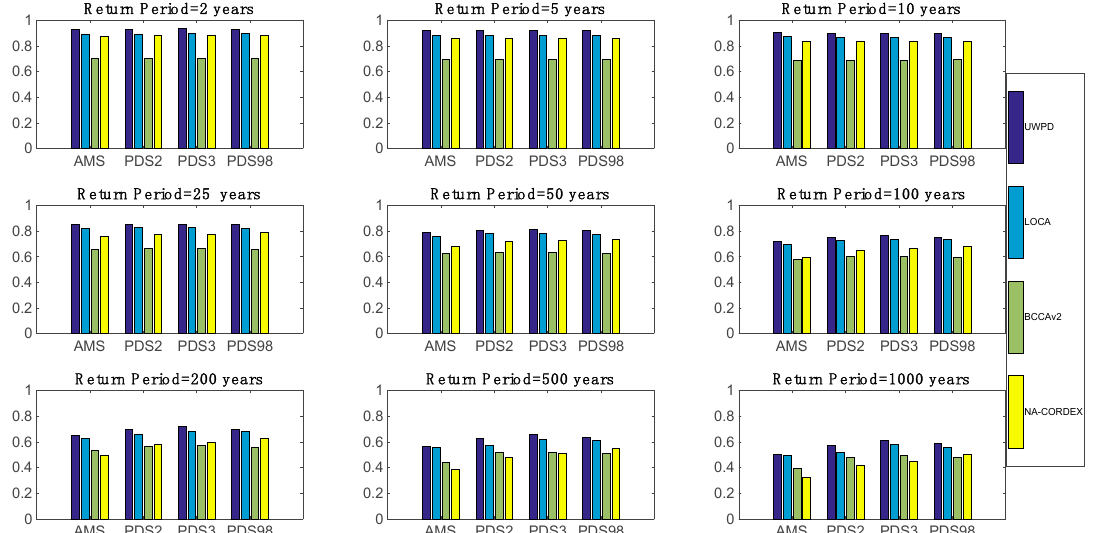
Figure 6. PF correlations between OB and downscaled data for different return periods. PF estimate correlation skills of the four downscaled data sets for different return periods: UWPD (dark blue), LOCA (light blue), BCCAv2 (light green), and NA-CORDEX (yellow).